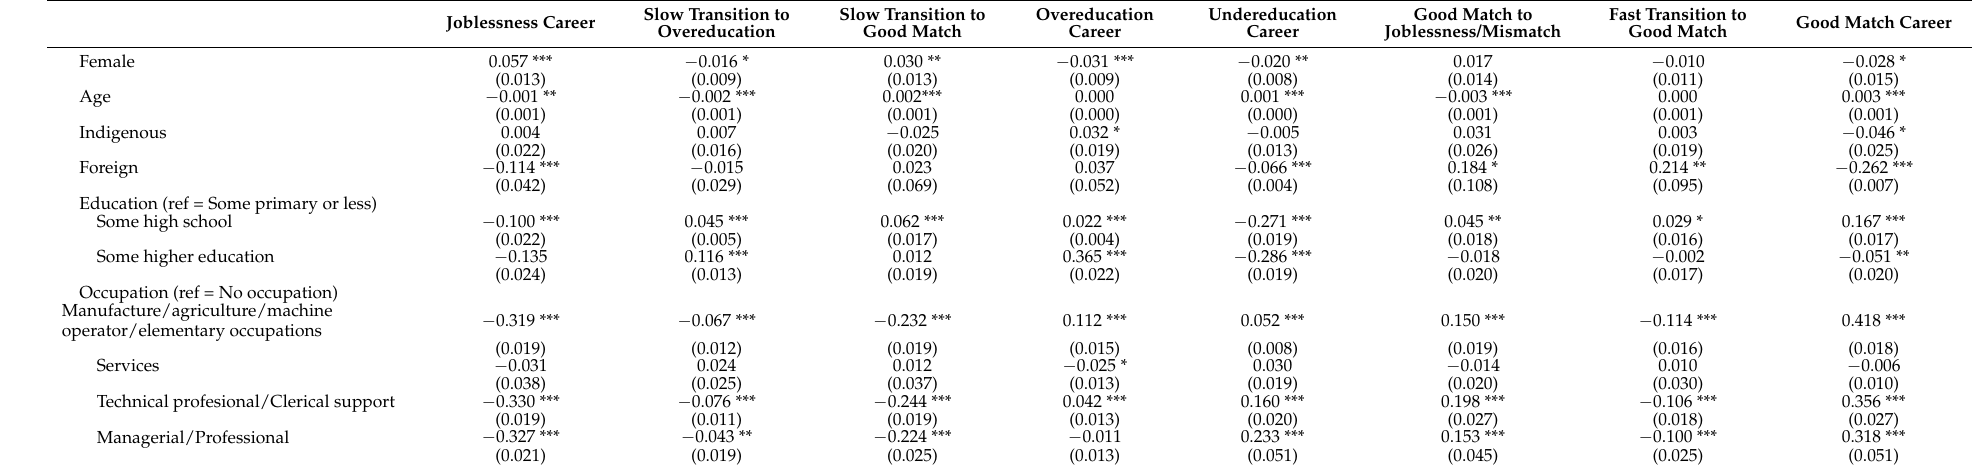
Table A4. Multinomial logistic model (marginal effects) of individual characteristics on mismatch career trajectories. Joblessness Career Slow Transition to Overeducation Slow Transition to Good Match Overeducation Career Undereducation Career Good Match to Joblessness/Mismatch Fast Transition to Good Match Good Match